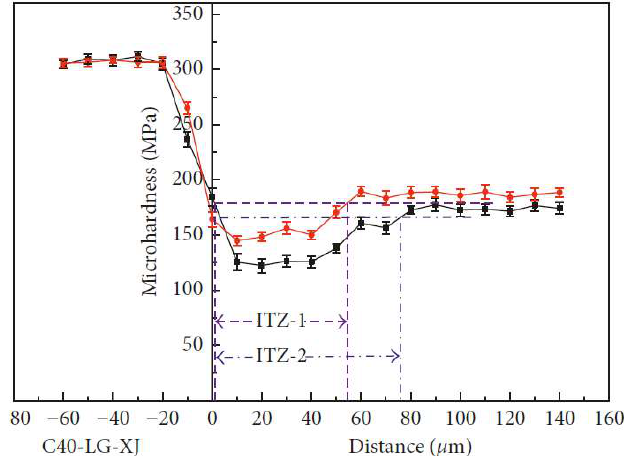
Figure 8. Effect of carbonation treatment on the microhardness of ITZ [39]. Reproduced with permission from [39], Hindawi, 2018.